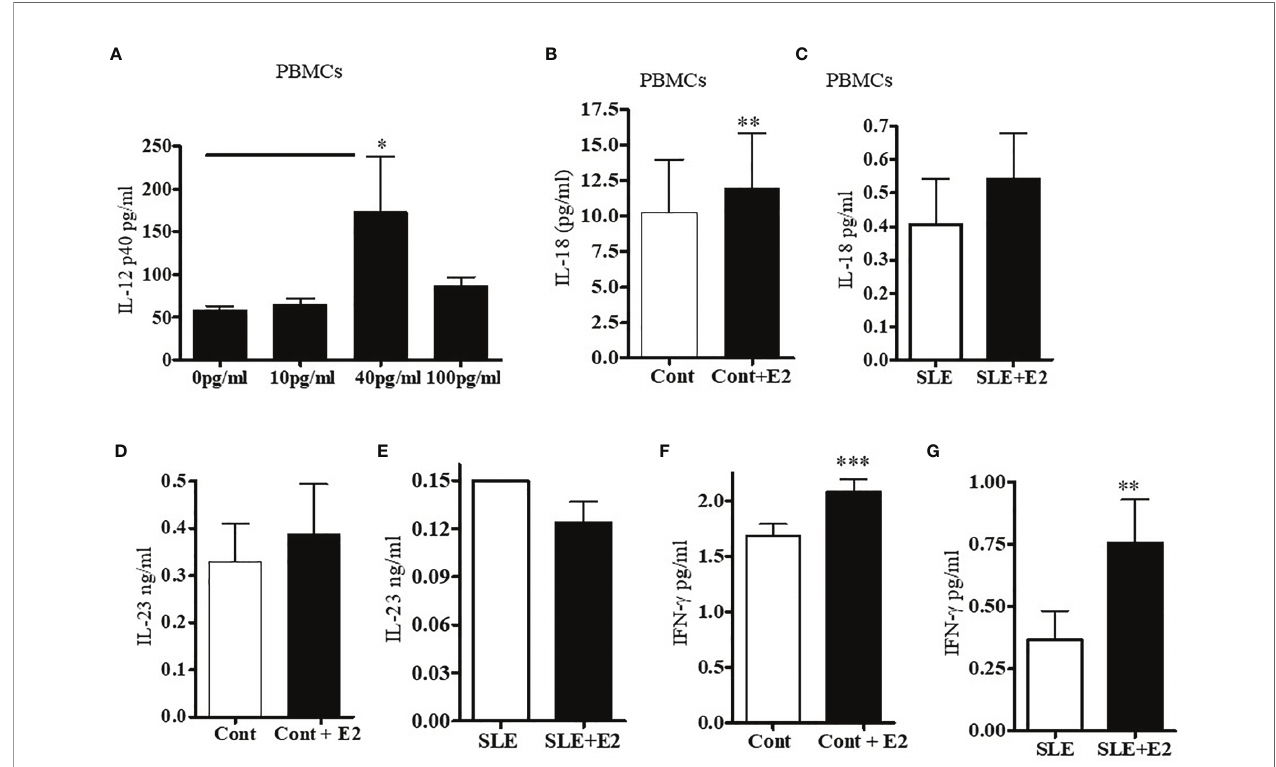
FIGURE 6 | 17 b -estradiol increases pro-in fl ammatory cytokines IL-12p40, IL-18, and IL-23 in SLE patients compared to healthy controls. PBMCs from female SLE patients (n=7) were obtained and 2-4x10 6 cells were cultured with 17 b -estradiol (E2 at 10, 40 and 100 pg/ml) for 24-48 h. Culture supernatants were obtained. (A) IL-12p40 levels were measured with ELISA (BioLegend). *p < 0.05. (B) IL-18 levels were measured in the supernatant of healthy control PBMCs treated with E2 (50 pg/ml) (n=11). (C) IL-18 levels were measured in the supernatant of SLE patients PBMCs treated with E2 (50 pg/ml) (n=11). (D) IL-23 levels were measured in the supernatant of healthy control PBMCs treated with E2 (50 pg/ml) (n=8). (E) IL-23 levels were measured in the supernatant of SLE patients PBMCs treated with E2 (50 pg/ml) (n=9). (F) PBMCs (4x10 6 ) of healthy controls (n=9) were cultured with 17 b -estradiol (50 pg/ml). Culture supernatants were obtained after (24-48 h) and the level of secreted IFN g was measured with multiplex assay (RBM-MAP, Austin, TX, USA). *p < 0.05. (G) IFN g levels were measured in the supernatant of SLE patients PBMCs treated with E2 (50 pg/ml) (n=8). *p < 0.05, **p < 0.01, ***p <